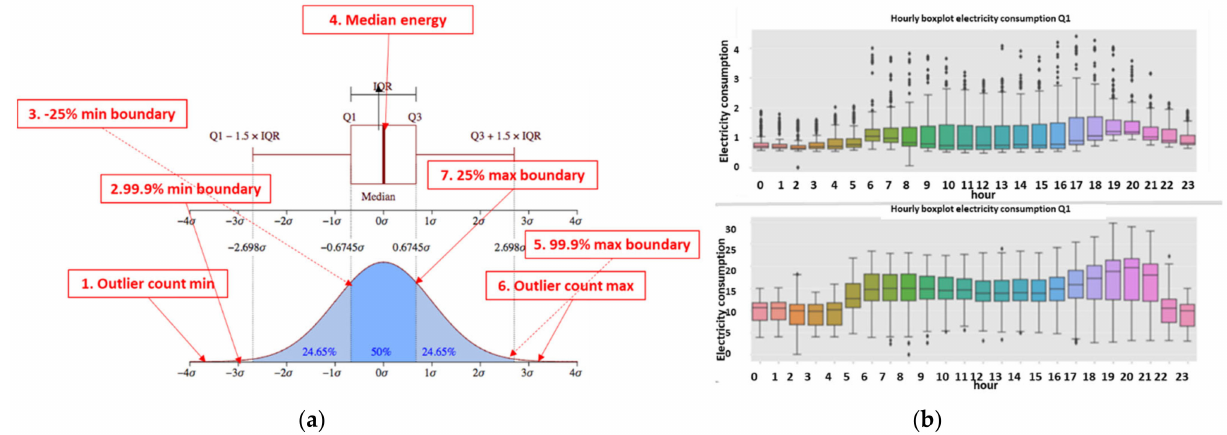
Figure 12. ( a ) Left is the boxplot split into seven features, ( b ) right-upper is verified fraud vs. lower verified non-fraud. Here, fraud is actual fraud. Technical loss type differentiation is